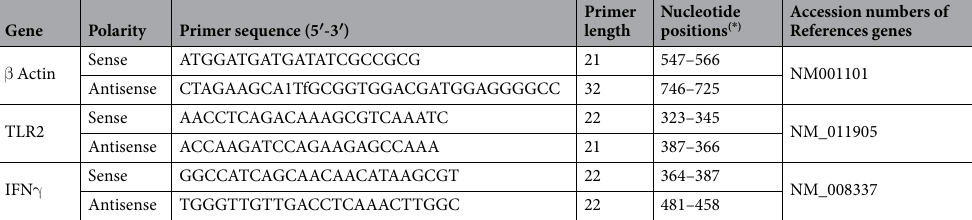
Table 4. Primers used for TLR2, IFN γ , and β Actin genes expression quantitation using SybergreenqRT-PCR. ( * )Nucleotide position numbering is based on reference genes sequences that were retrieved from DDBJ/